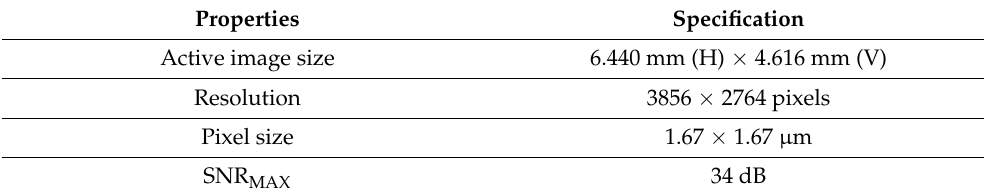
Table 2. Aptina MT9J001 specifications.